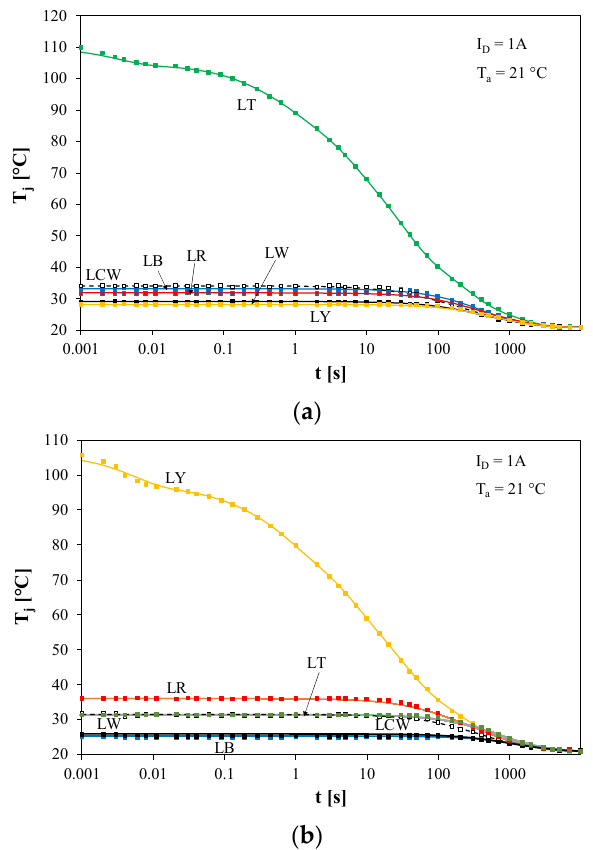
Figure 10. Computed and measured waveforms of junction temperatures of the investigated power LEDs while cooling after power is supplied to a single diode only: ( a ) the LT diode and ( b ) the LY diode.